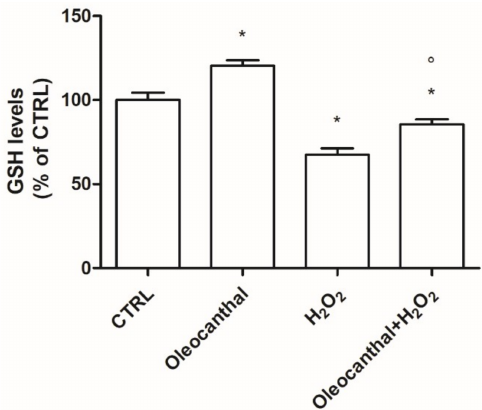
Figure 3. Effect of oleocanthal on GSH levels in differentiated SH-SY5Y cells. Cells were treated with 10 µ M oleocanthal and after 24 h were exposed to peroxide. GSH levels were measured using the fluorescence probe MCB as reported in Materials and Methods. Each bar represents the mean ± SEM of four independent experiments. Data were analyzed by one-way ANOVA followed by Bonferroni’s test. * p < 0.05 with respect to CTRL; ◦ p < 0.05 with respect to H 2 O 2